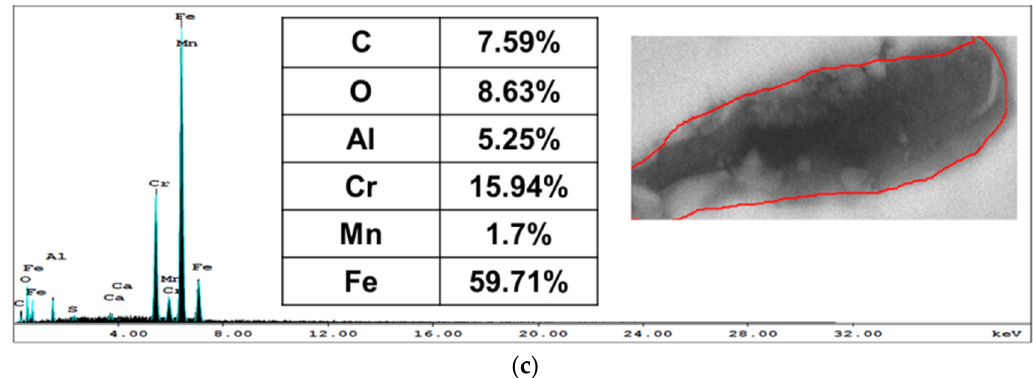
Figure 2. Energy dispersive X ‐ ray (EDX) analyses of AR AISI416: ( a ) MnS inclusions; ( b ) carbide particles; and ( c ) multi ‐ element oxides.